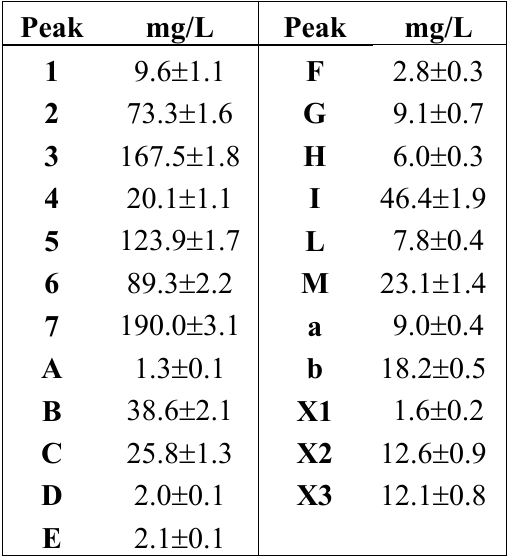
Table 1. Content of flavanone-O-glycosides ( 1-7 ), flavone-C-glucosides ( A-H ), flavone- O- neohesperidosides ( I-M ), cinnamic acid derivatives ( X1-3 ) and furanocoumarins ( a-b ) in